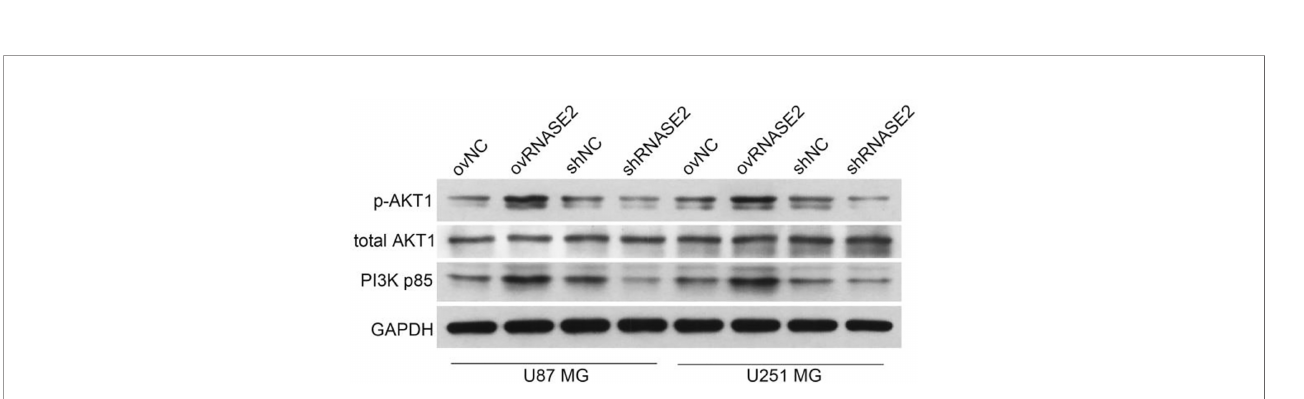
FIGURE 5 | RNASE2 overexpression activates the PI3K/Akt signaling pathway, while RNASE2 knockdown inactivates it. RNASE2-overexpressing (ovRNASE2) and RNASE2-silenced (shRNASE2) cells were constructed. The ovNC or shNC groups were used as control cells. RNASE2 overexpression upregulated, while RNASE2 knockdown downregulated, the protein levels of p-AKT1 and PI3K p85. RNASE2 had no effect on total AKT1